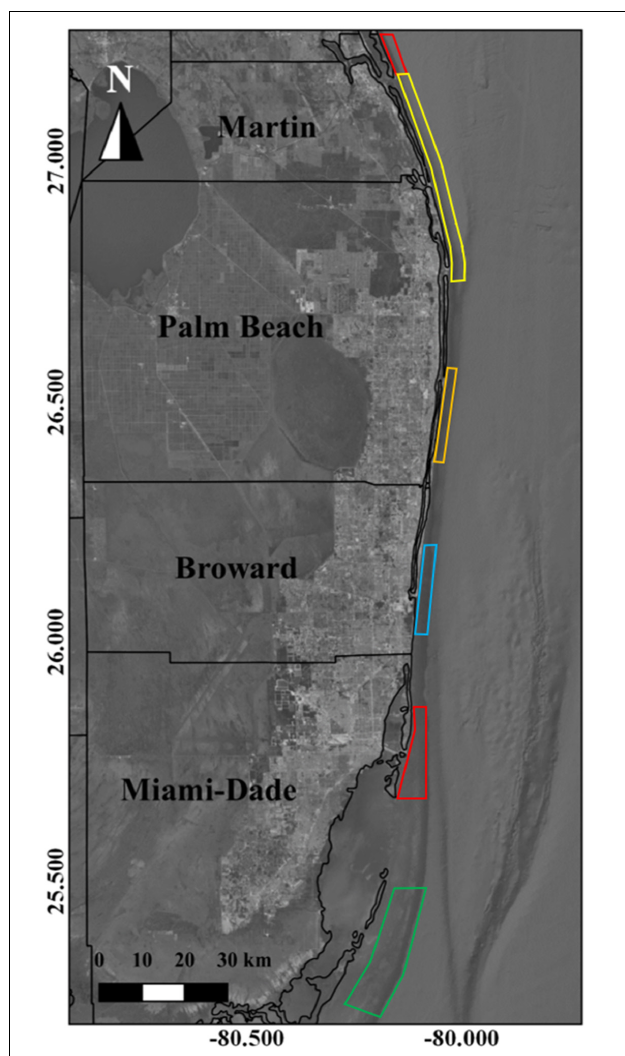
FIGURE 3 | Extent of reports of FSAs for gray snapper (red), goliath grouper (yellow), gag and goliath grouper (orange), hogfish and vermillion snapper (blue polygon), and mutton snapper